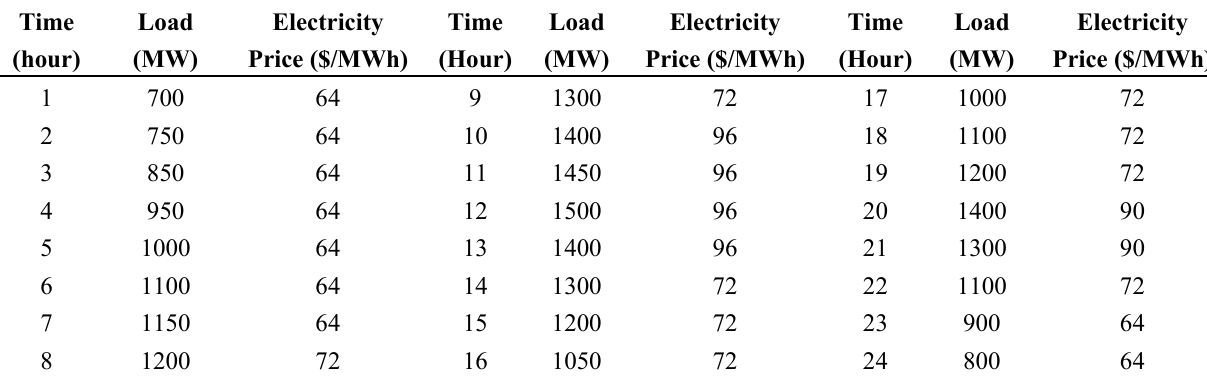
Table 7. The original load demand and peak-valley electricity